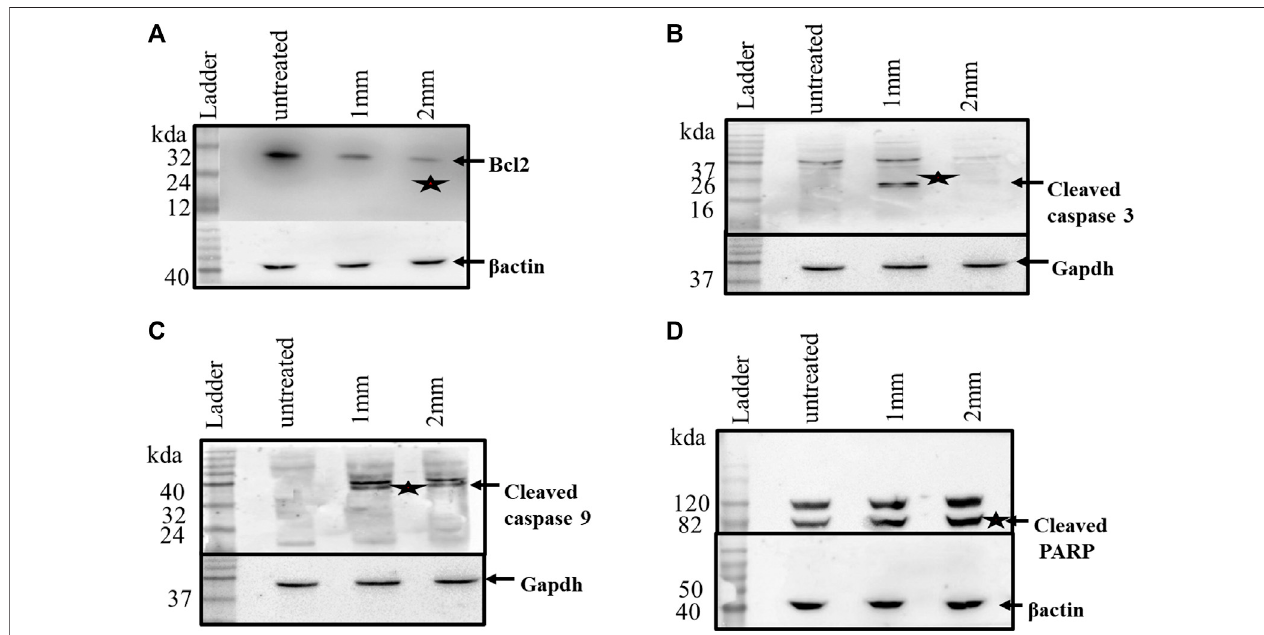
FIGURE 7 | HCT116 cells treated with GIV and analyzed for expression of apoptosis-associated proteins. (A) Expression of Bcl2 in the control and GIV-treated cells. (B) Cleaved caspase-3 protein levels in the control and GIV-treated cells. (C) Cleaved caspase-9 protein levels in the control and GIV-treated cells. (D) Cleaved PARP levels in the control and GIV-treated cells. β -actin and GAPDH proteins have been used as the internal